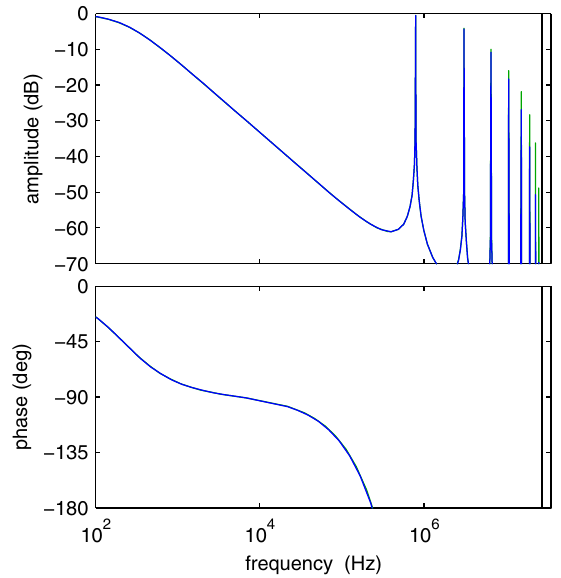
FIG. 10. (Color) Bode plot of the discrete single cavity open loop transfer function (blue) for 54 MHz sampling rate, unity gain G (cid:3) 1 , and loop delay (cid:4) bode plot of the continuous system is also shown (green). The digitalization attenuates the 8